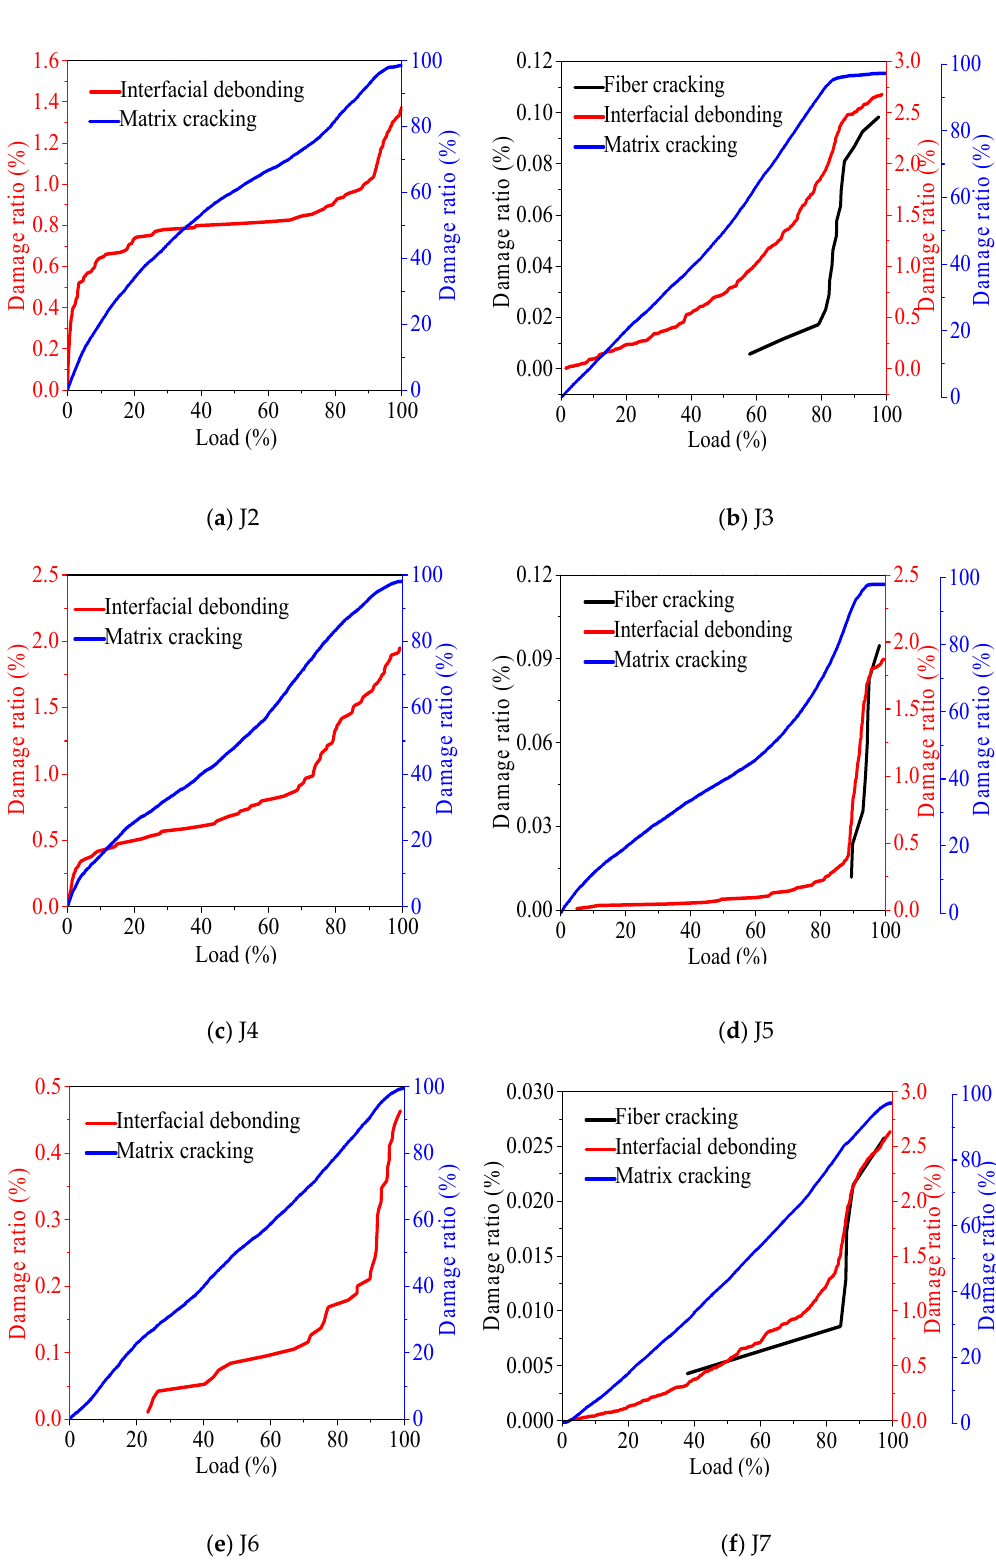
Figure 9. The influence of basalt fiber on the failure state of concrete.